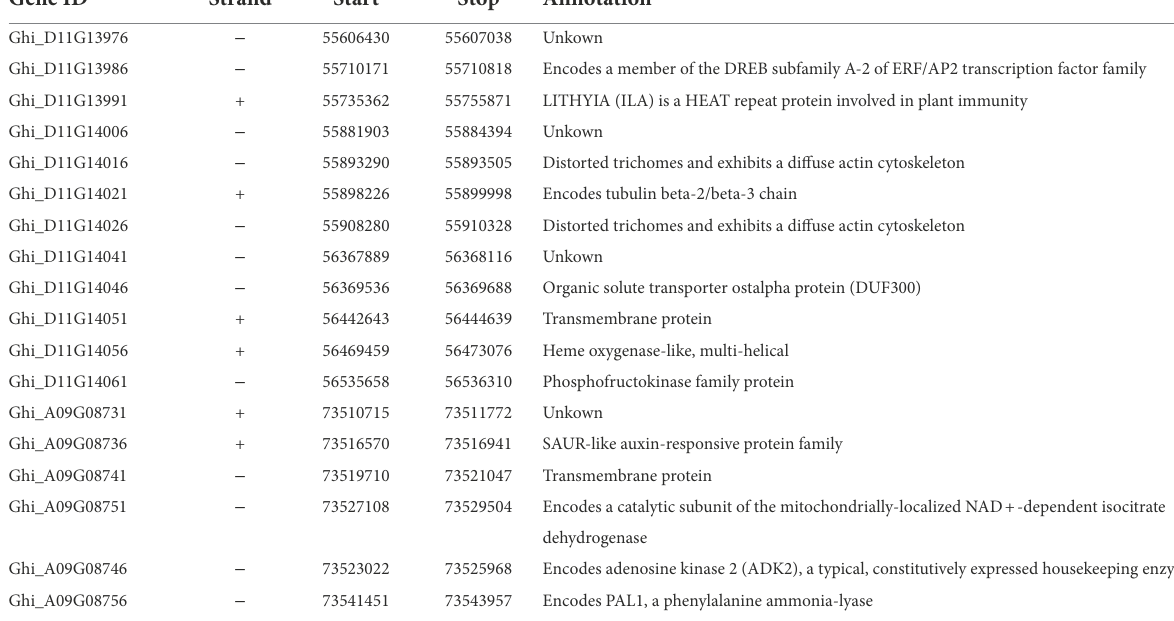
TABLE 2 Candidate genes in locus FBA and its annotation in GWAS. Gene ID